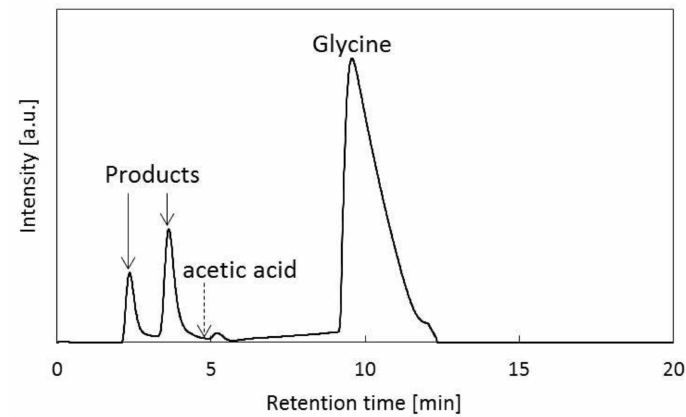
Figure 4. Chromatogram of the product by the treatment of 1000 discharge plasma pulses at 18.6